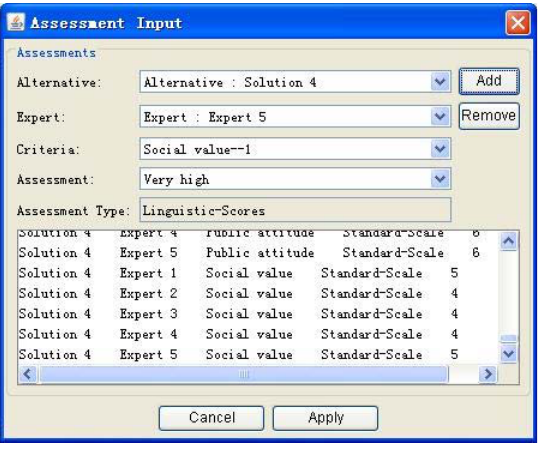
Fig.11. Assessment input for all alternatives under all criteria